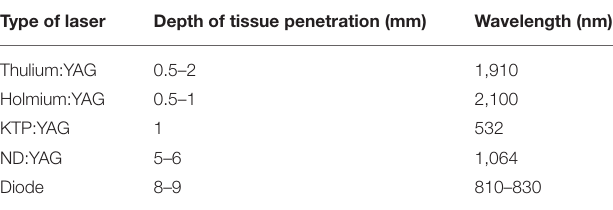
TABLE 1 | Depth of tissue penetration by type of laser (29–34). Type of laser Depth of tissue penetration (mm)